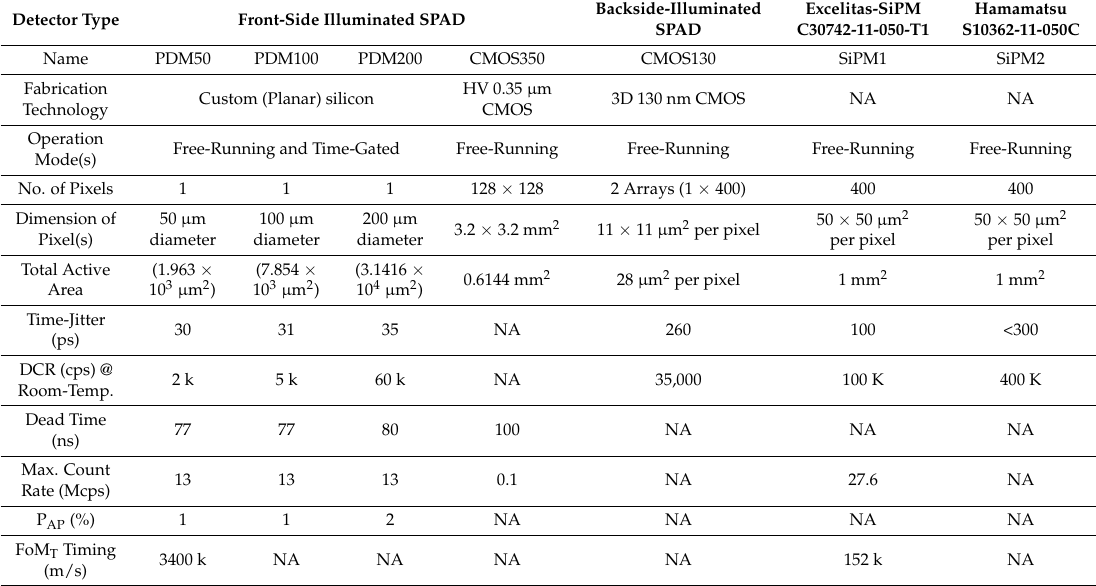
Table 1. Main features of SPADs and SiPM detectors used in TR-DOI prototypes.